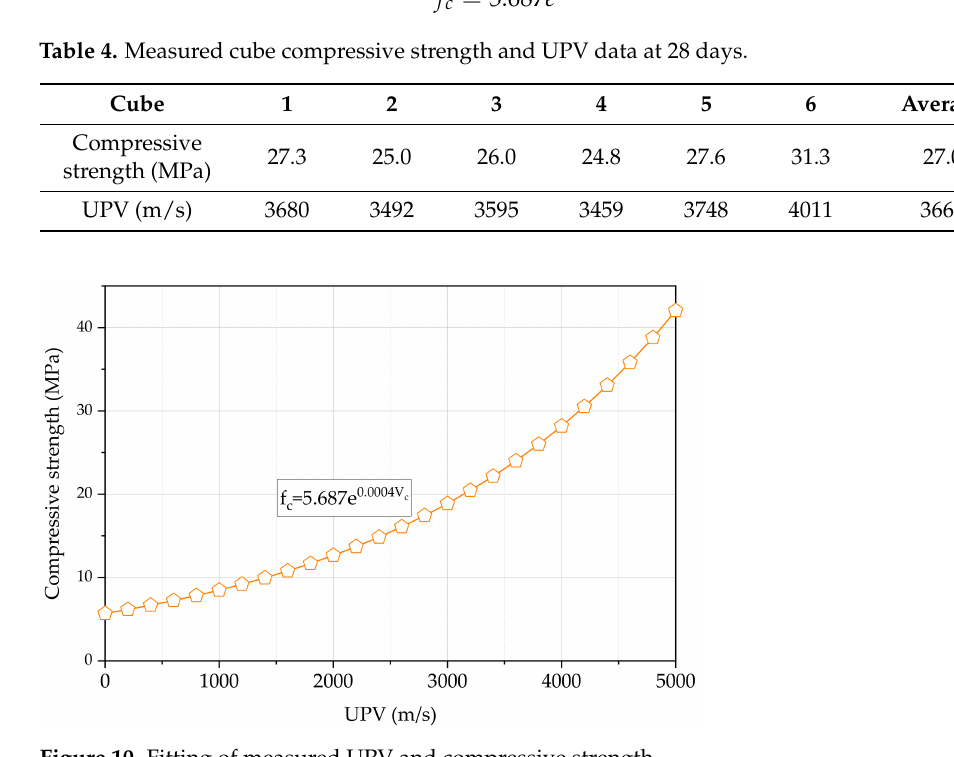
Figure 10. Fitting of measured UPV and compressive strength.